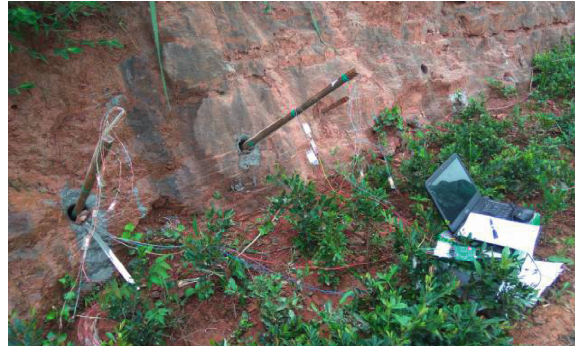
Figure 4: Field test chart of self-expansion anchoring.